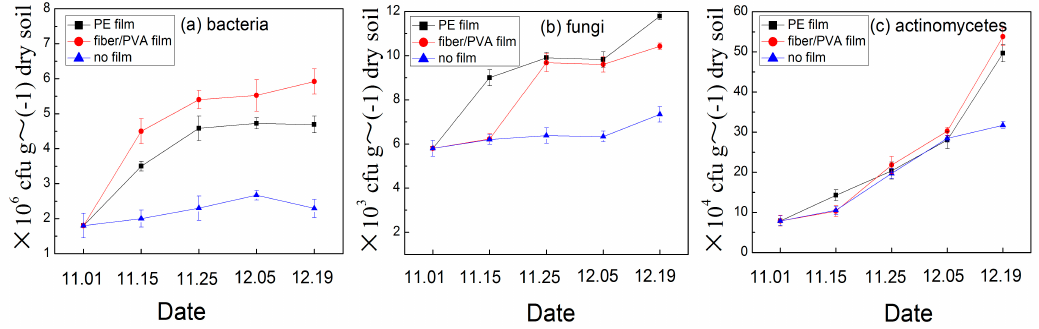
Figure 5. The amount of microorganisms in soil covered by different films between November 1, 2014 and December 19, 2014.